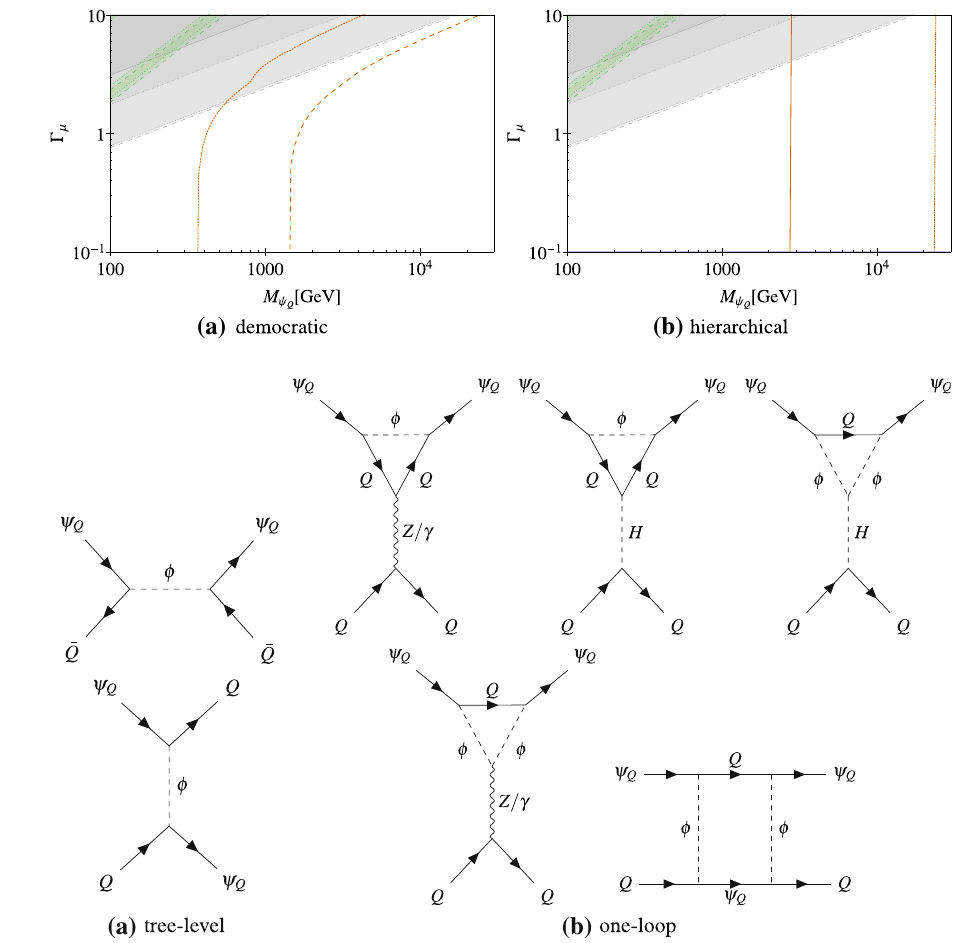
Fig. 9 Summary plot for Dirac DM in bIIB. The legend and an explanation of the color scheme are given in Fig.4